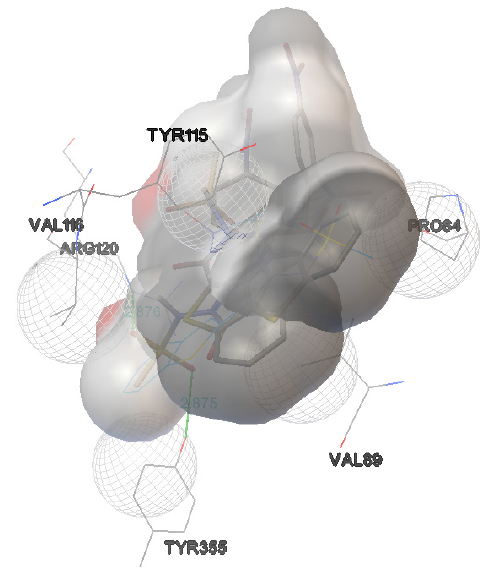
Figure 6. Binding of 9 into the active site of